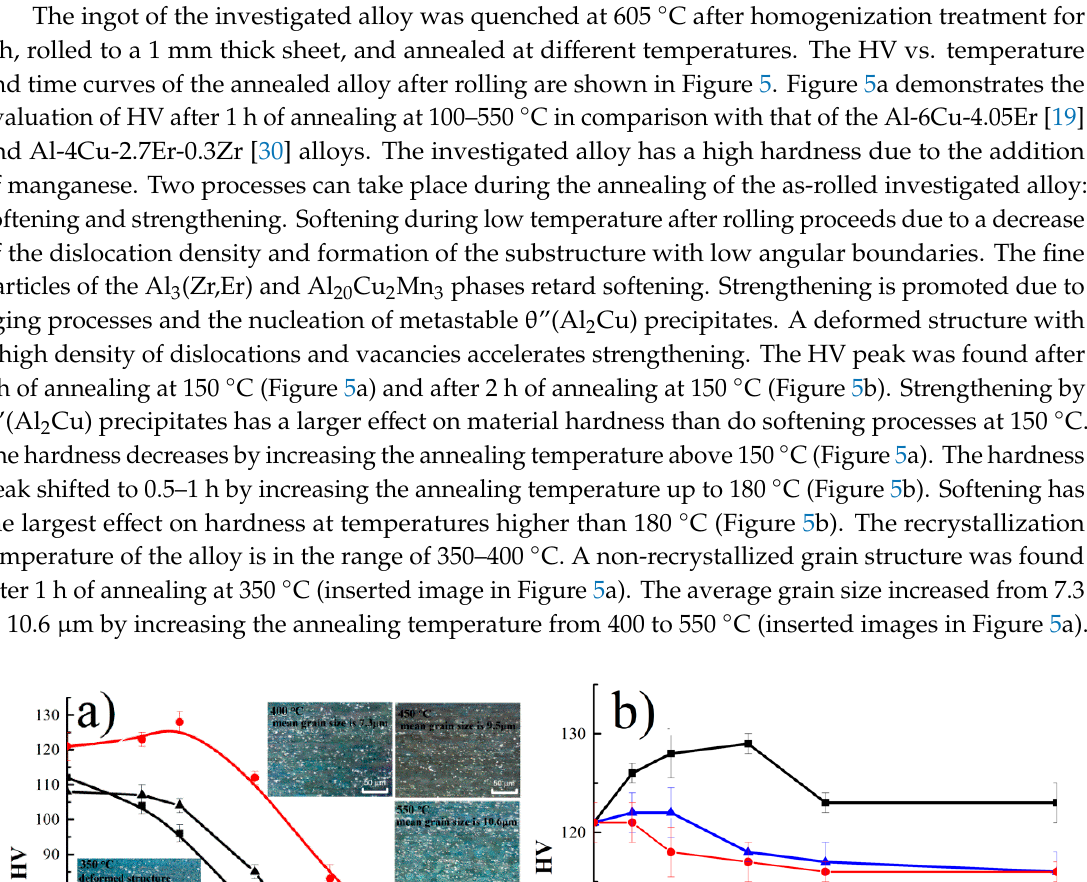
Table 2. Tensile tests results. YS: yield strength; UTS: ultimate tensile strength.